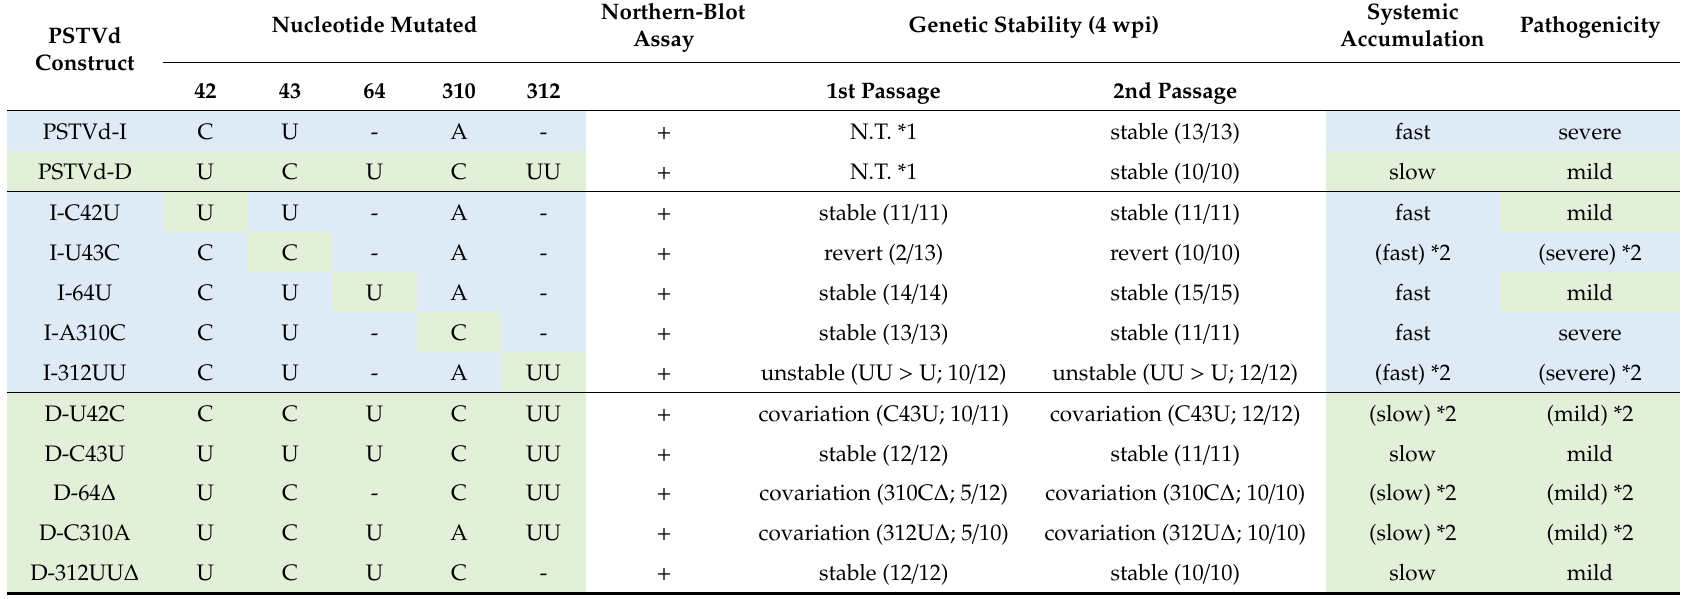
Nucleotides with blue background indicate PSTVd-I-type and those with green background indicate PSTVd-D-type. Numbers in parentheses indicate the number of cDNA clones which maintained stably or reverted to wild type or produced co-variation(s) per total sequence analyzed. *1. N.T. means not tested. *2. Since these mutants did not replicate stably, systemic accumulation and pathogenicity do not indicate the attributes of the original mutant